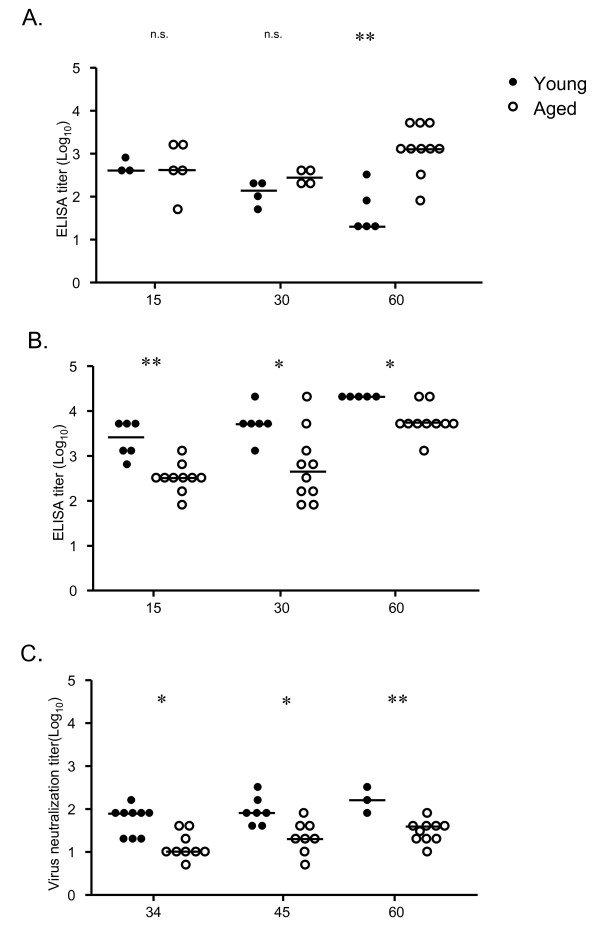
Aged mice produce reduced serum titers of class switched antibody and reduced neutralization titers following de novo γHV68 infection. Serum titers of γHV68-specific IgM (A) and IgG (B) were measured by ELISA in young (3 months old, closed symbols) and aged (19-24 months old, open symbols) C57BL/6 mice at 15, 30, and 60 days post infection. (C) The virus neutralization activity of sera at 34, 45, and 60 days post infection was determined as described in the Materials and Methods. Each symbol represents data obtained from an individual mouse and bars indicate the medians calculated from the data shown. Statistical significance was determined using the Mann-Whitney test.**; P ≤ 0.01. *; P ≤ 0.05.